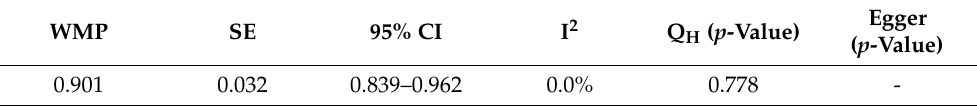
Table 3. Meta-analysis results referring to papilla index grade 2–3. Caption: WMP = weighted mean prevalence; SE = standard error; CI = confidence interval; QH ( p -value) = Cochrane Q of heterogeneity.